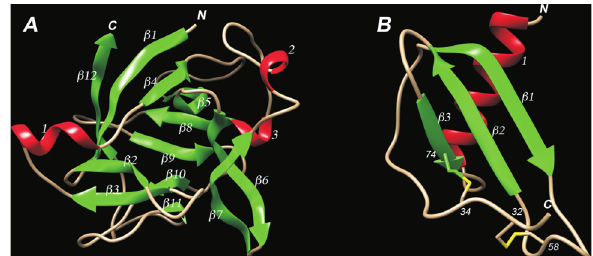
Figure 5 - Homology based three-dimensional modeling of pmIL-1 (cid:2) (A) and pmIL-8 (B) presented as ribbon diagrams. Amino- and carboxyl- termini regions are indicated with the letters “N” and “C”, respectively. (A) predicted tertiaty structure of pmIL-1 (cid:2) monomer showing 12 con- served (cid:2) -strands(green)and3 (cid:5) -helices(red).(B)predictedterciarystruc- ture of pmIL-8 monomer showing 3 (cid:2) -strands (green), 1 (cid:5) -helix (red) and 2putativedisulfidebonds(yellow)betweenCys 32 -Cys 58 andCys 34 -Cys 74